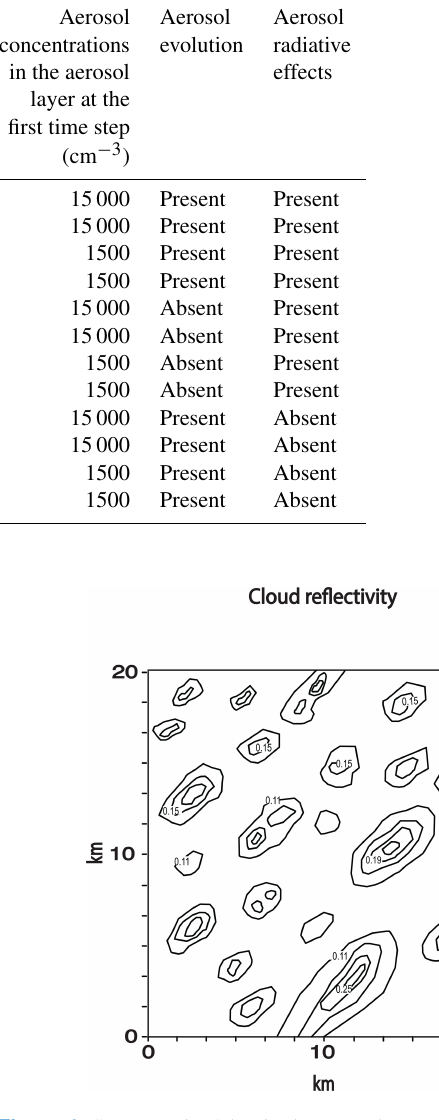
cloud cells between the observed and simulated fields. Ta- ble 3 shows comparisons of cloud and environmental vari- ables between observations and the control run. Observations are performed by ground stations and satellites. Note that ground stations which measure PM 2 . 5 as marked in Fig. 1b also measure cloud and environmental variables. Table 3 shows that differences in those variables between observa- tions and the control run are ∼ 10 %. This and Fig. 6 indicate that the control run can be considered to have performed rea- sonably